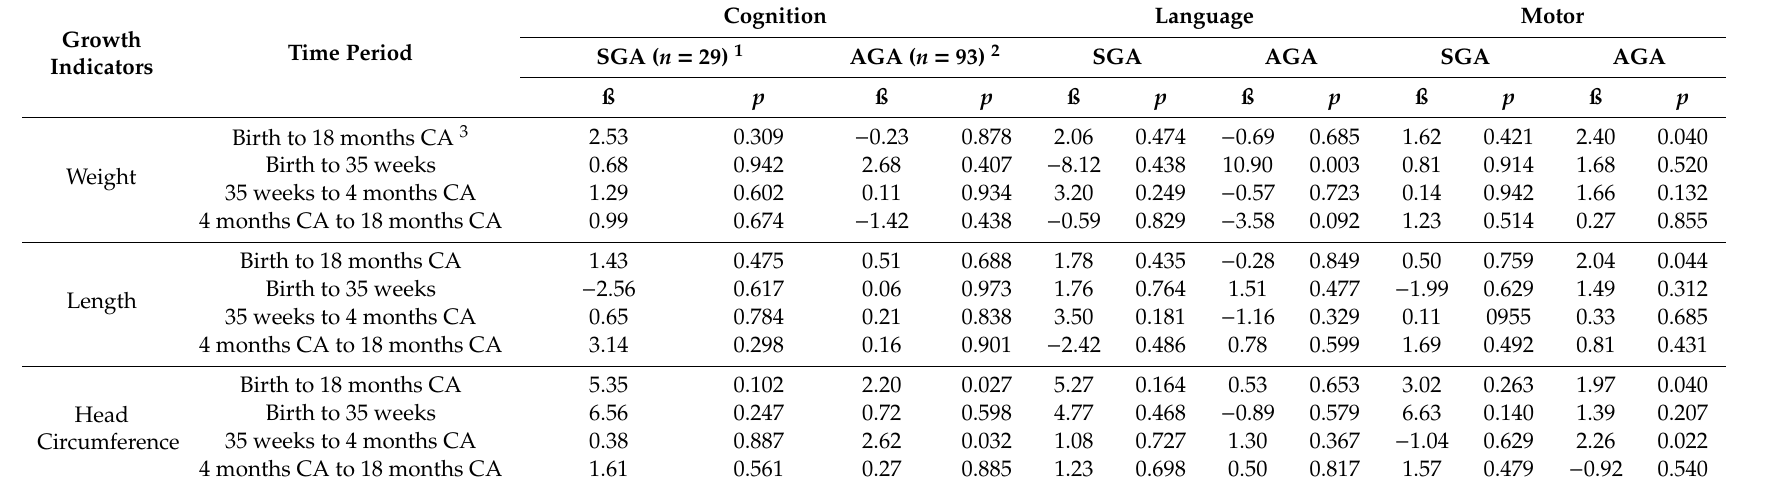
Table 3. Correlations between growth from birth to 18 months of corrected age and 18-month Bayley